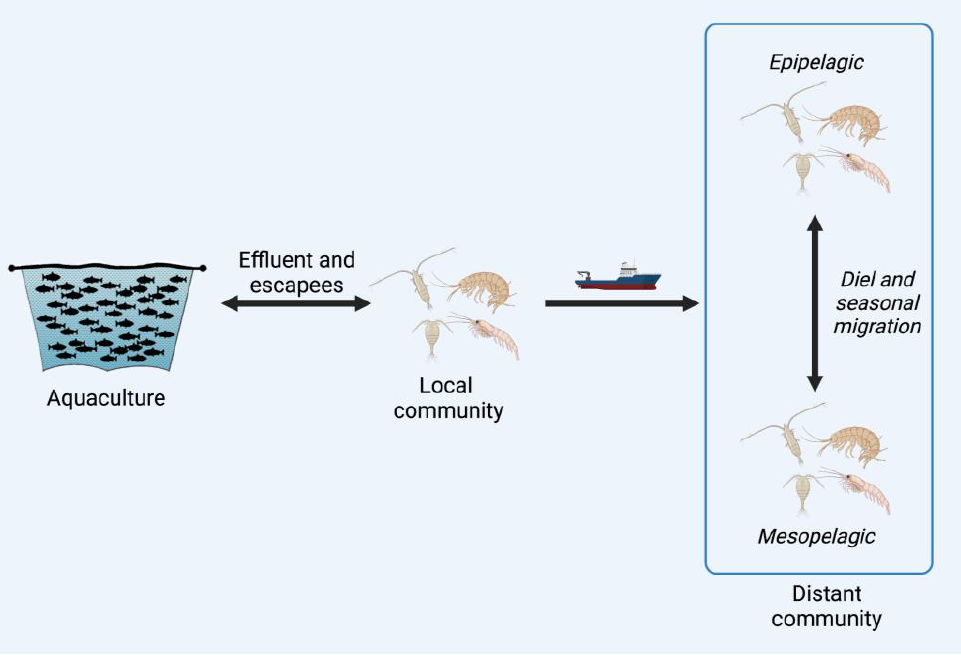
Figure 2. Crustacean zooplankton can vector viruses horizontally and vertically in the ocean. Viruses are transmitted among wild crustaceans or move between aquaculture pens and the local crustacean community through escapees, effluent or vectors. Viruses harboured in the wild are also transported into open net pens by zooplankton, where host density and environmental conditions are conducive to disease development. Diel or seasonal vertical migration of zooplankton transports organic matter between deep water and the mixed layer, with the potential to transmit pathogens including viruses. Long-distance transport of viruses carried by zooplankton in ship ballast should also examined as a mechanism of viral spread.